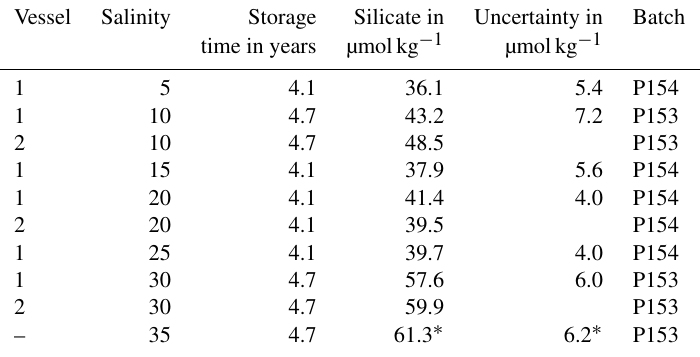
Table 3. Dissolved silicate molality of some DSW samples. Vessel Salinity Storage Silicate in Uncertainty in Batch time in years µmolkg −